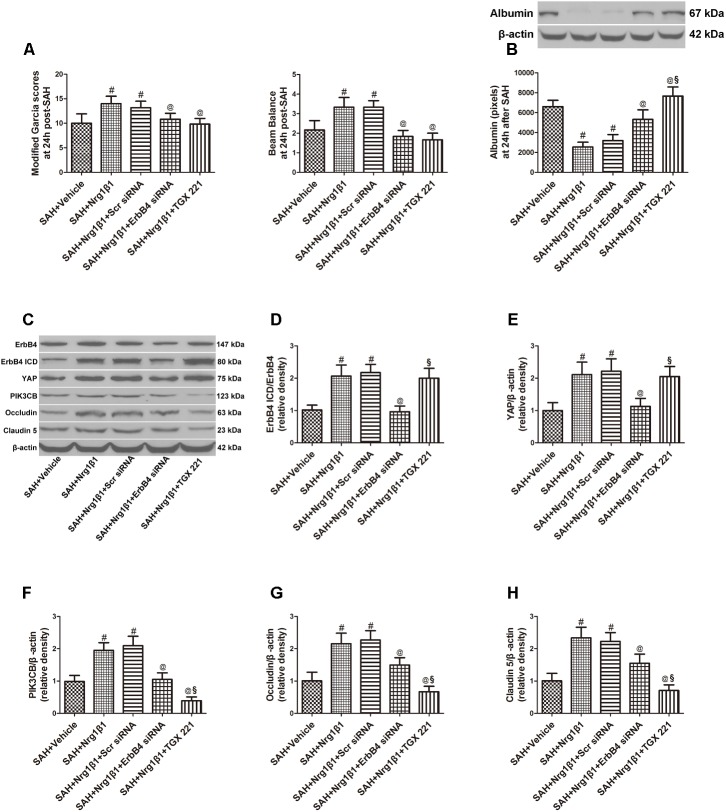
Effects of ErbB4 siRNA pre-treatment on blood-brain barrier integrity at 24 h after SAH. ErbB4 siRNA aggravated neurological deficits (A) and increased albumin extravasation (B). Representative western blot bands of ErbB4, YAP, PIK3CB, Occludin and Claudin 5 (C). ErbB4 knockdown decreased the expression of ErbB4 ICD/ErbB4 (D), YAP (E), and PIK3CB (F). The increased expression levels of Occludin and Claudin-5 after Nrg1β1 treatment were significantly reduced by ErbB4 depletion (G,H). The PIK3CB specific inhibitor TGX 221 did not affect the expression of ErbB4 ICD/ErbB4 (D), YAP (E) and significantly reduced the expression of PIK3CB (F), Occludin (G) and Claudin-5 (H). n = 6, #p < 0.05 versus SAH + vehicle; @p < 0.05 versus SAH + Nrg1β1; §p < 0.05 versus SAH + Nrg1β1 + ErbB4siRNA.